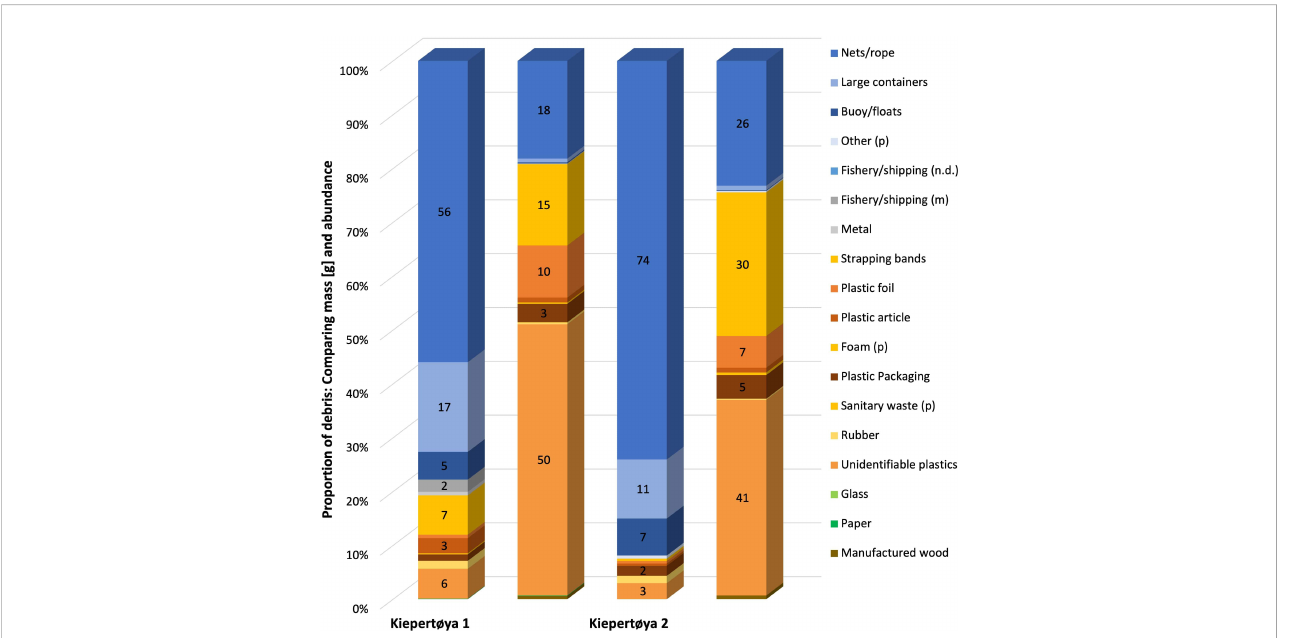
FIGURE 8 High-resolution proportion of two big packs. Two columns are shown per location: mass (left columns) and abundance (right columns). P = plastic, m = metal, n.d. = not de fi